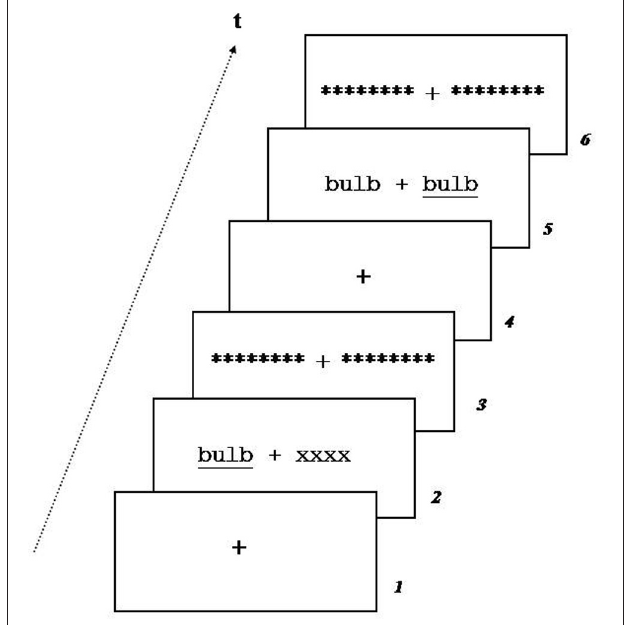
FIGURE 2 | Example of trial during unilateral (1) and (2) bilateral redundant presentation. A fixation cross was presented for 500ms, followed by stimulus presentation for 180ms, mask during 30ms and fixation cross for